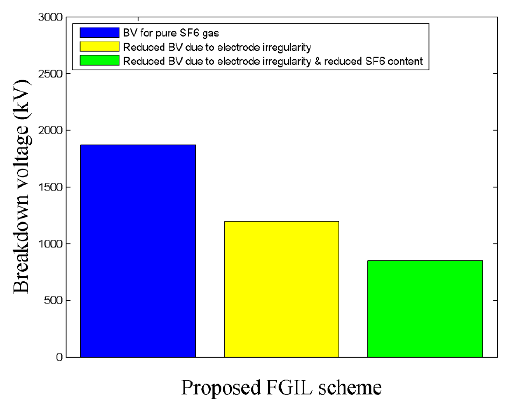
Figure 18. Breakdown voltage (BV) for pure SF 6 in comparison to its reduction due to lesser SF 6 content, as well as electrode irregularity.